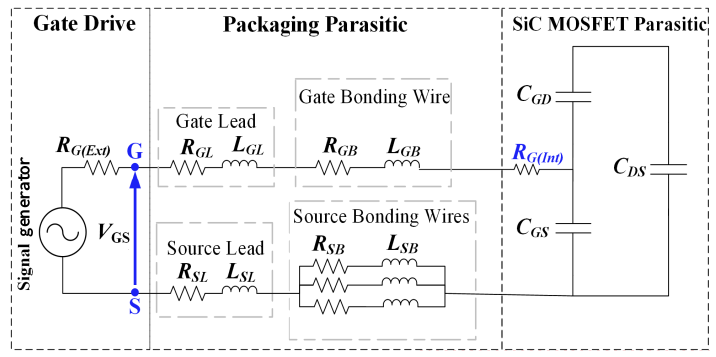
Figure 2. Off-state equivalent circuit of a SiC MOSFET.